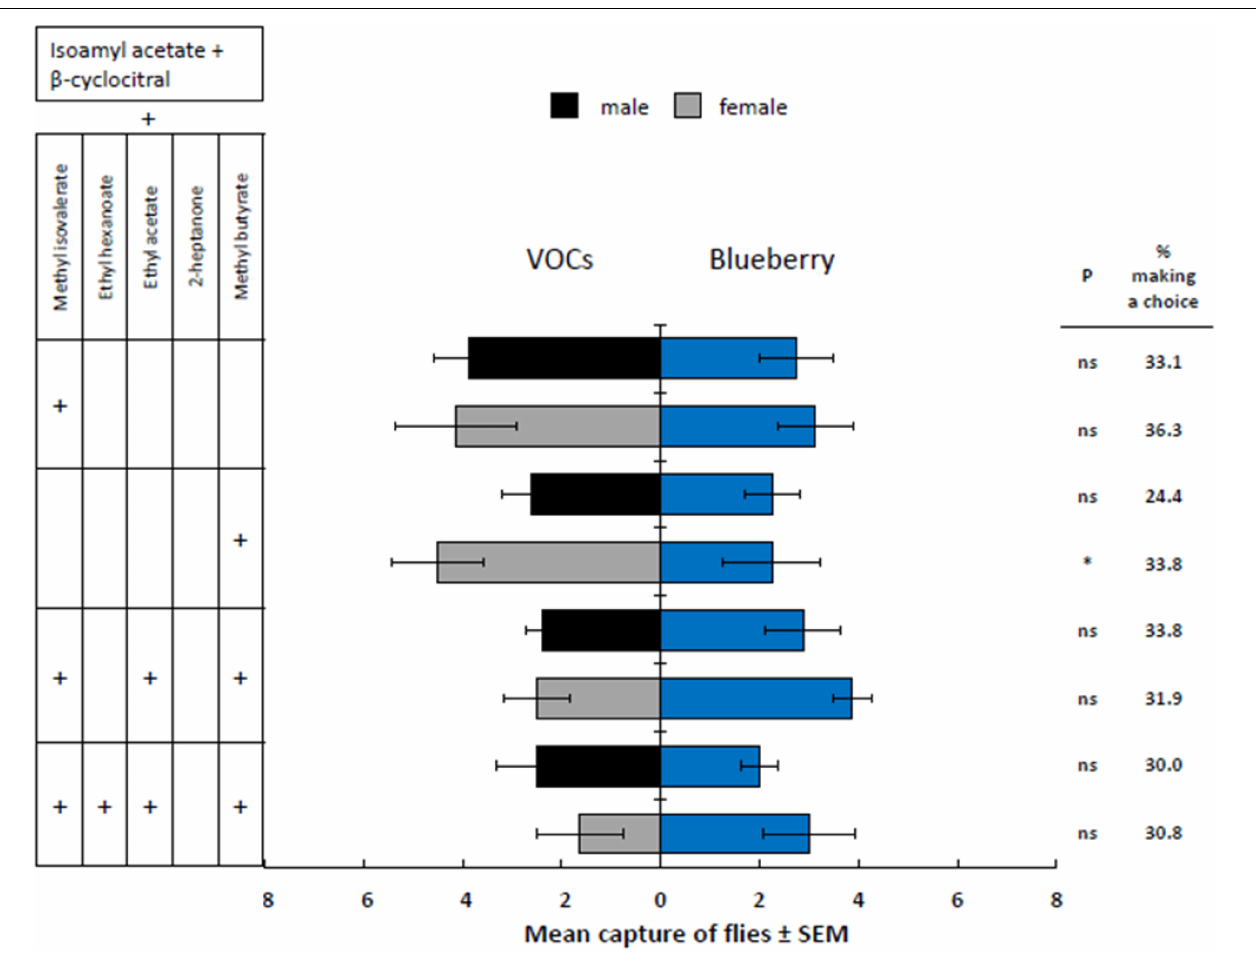
FIGURE 6 | Response of male and female D. suzukii to mixtures of fruit volatiles added to isoamyl acetate and β -cyclocitral (VOCs) against a whole blueberry (Blueberry). P -values with ∗ indicate P < 0.05 and “ns” indicates a non-significant difference where P >